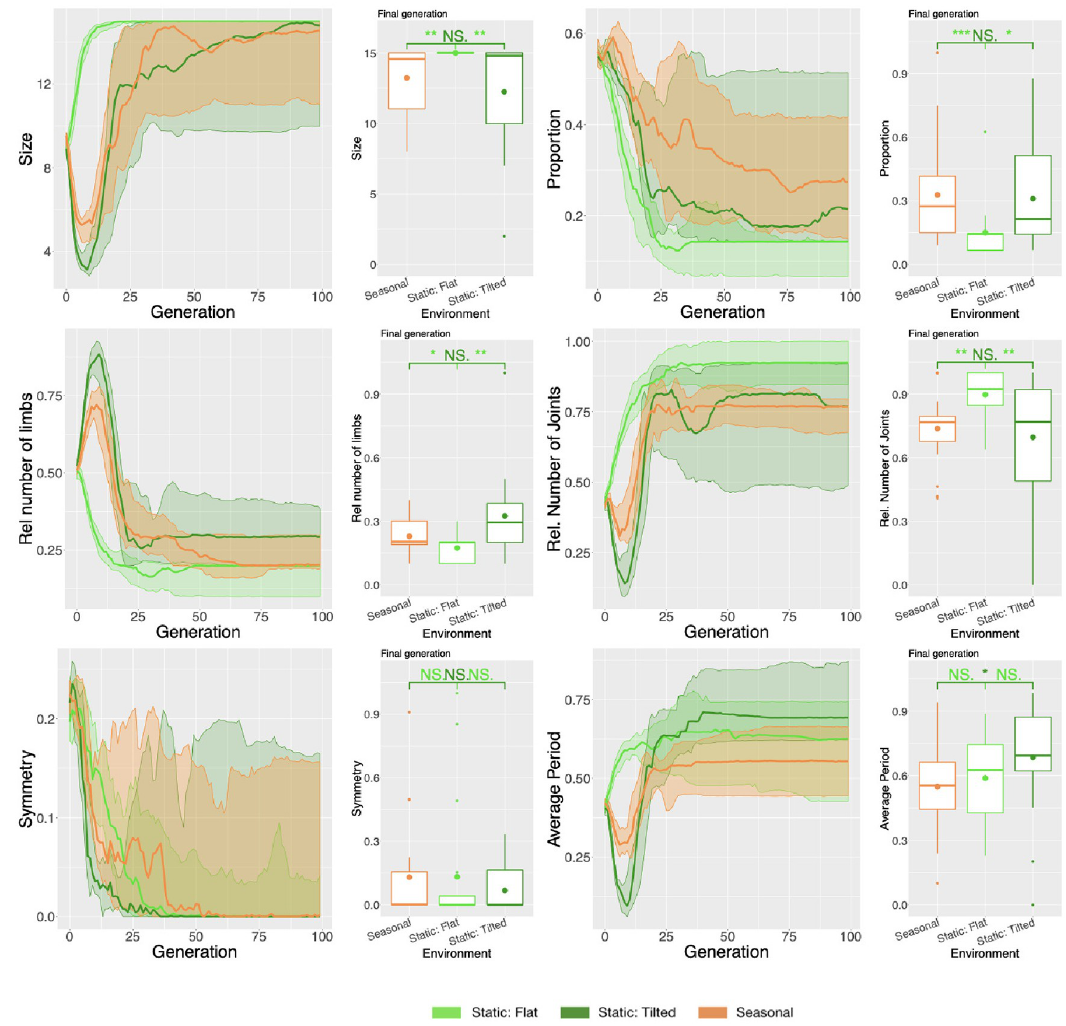
Fig 15. Comparison of morphological properties in different environmental conditions. Line plots show the progression of the mean of the population (quartiles over all runs), while boxplots show the mean of the population in the final generation. Significance levels for the Wilcoxon tests in the boxplots are � < 0.05, �� < 0.01, ��� < 0.001. Note that because phenotypic properties are the same in both environments for Seasonal, it is displayed only once in each